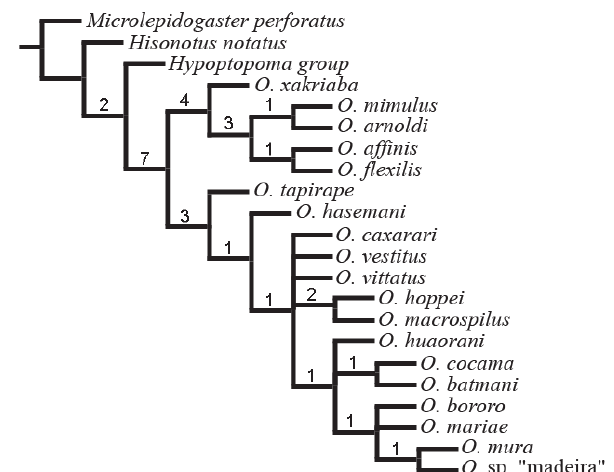
Fig. 7. Phylogenetic relationships among Otocinclus species. Strict consensus cladogram of three maximally parsimonious trees of 70 steps (CI = 60 and RI = 79). Numbers above branches are Bremer